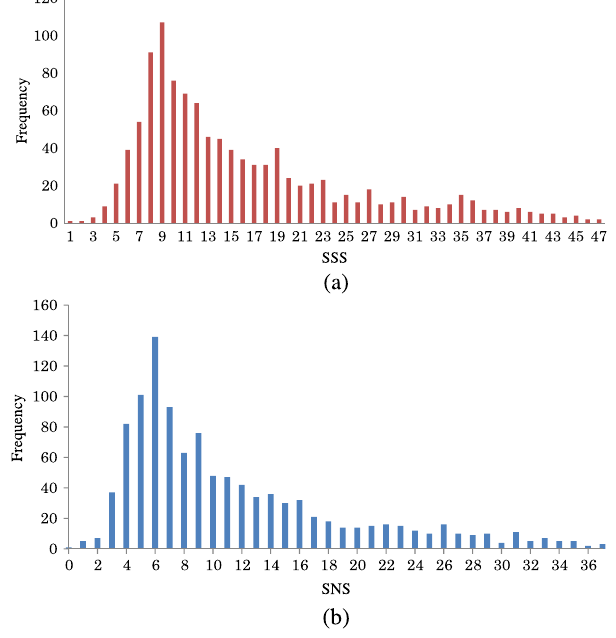
FIG. 2. Total score distributions of the pretest results of the FMCEJ. (a) The SSS distribution (47 pts) of the pretest results of the FMCEJ (mean ¼ 16 pts, median ¼ 13 pts, N ¼ 1095 students). (b) The SNS distribution (37 pts) of the pretest results of the FMCEJ (mean ¼ 11 pts, median ¼ 9 pts, N ¼ 1095 students).